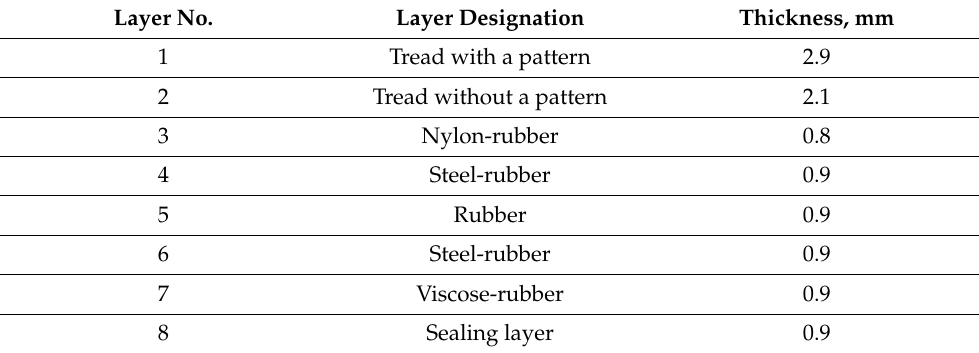
Table 5. Layer distribution of 175/70R13 82T tire bands. Layer